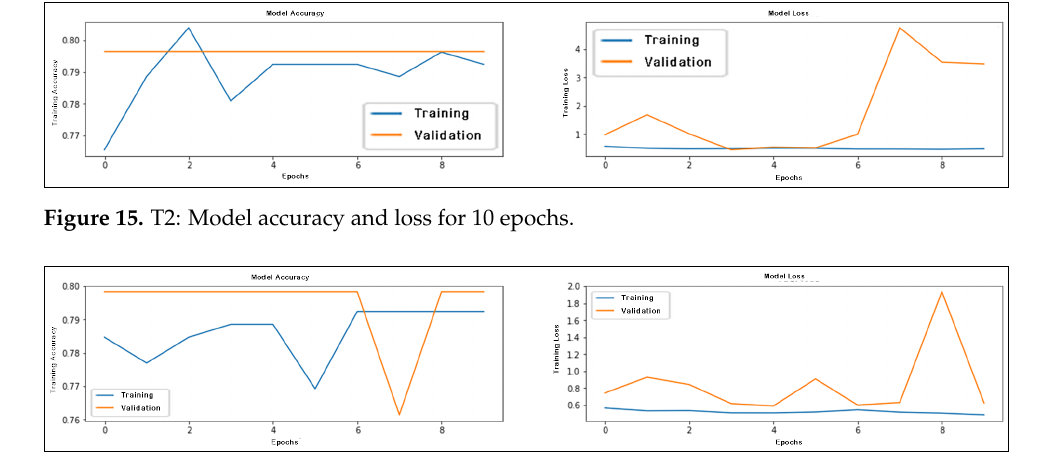
Figure 16. Flair: model accuracy and loss for 10 epochs.